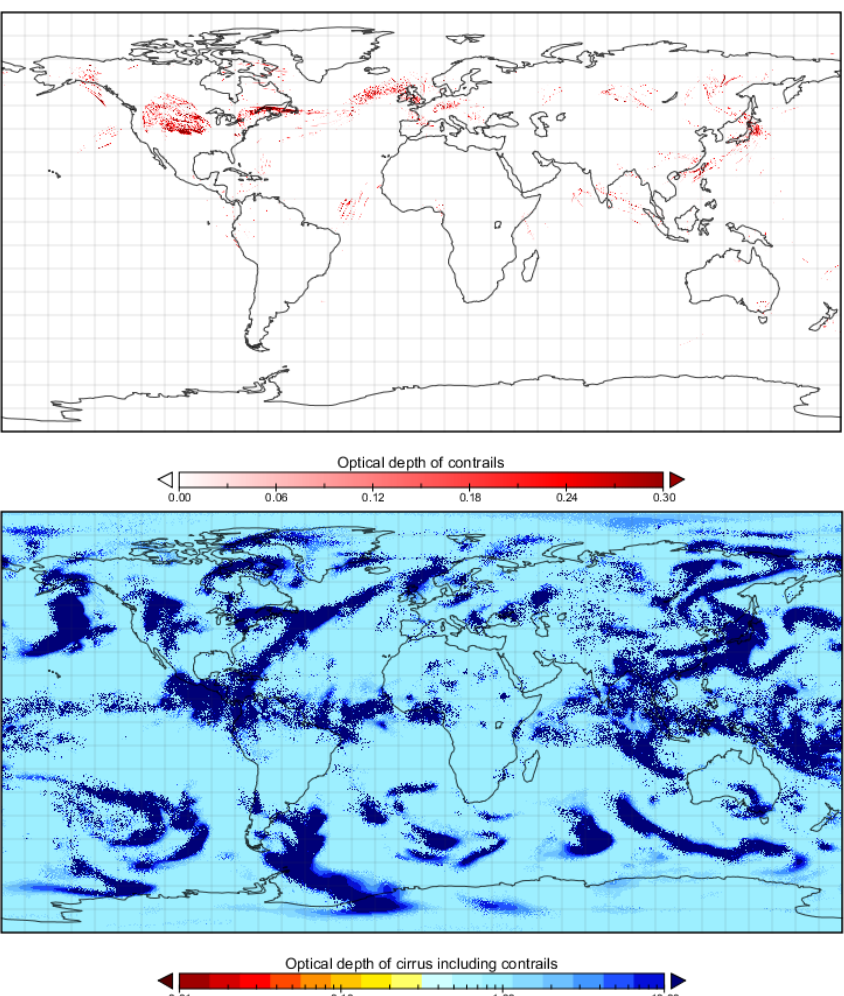
Fig. 11. Optical depth of contrail cover (top) and of cirrus and contrails (bottom) for traffic and time as in Fig. 6. Note, the data include cirrus above 6km altitude. The light blue background color indicates zero optical depth.